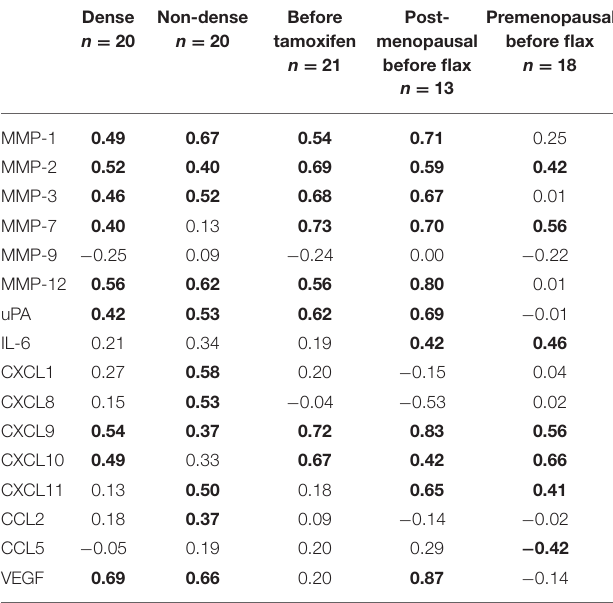
TABLE 2 | Subgroup analysis of the correlations between osteopontin and MMPs (matrix metalloproteinases), uPA (urokinase-type plasminogen activator), interleukin (IL), CXCL (chemokine (C-X-C motif) ligand), and CCL (Chemokine (C-C motif) ligand) in normal human breast tissue in vivo . Dense Non-dense n = 20 n =